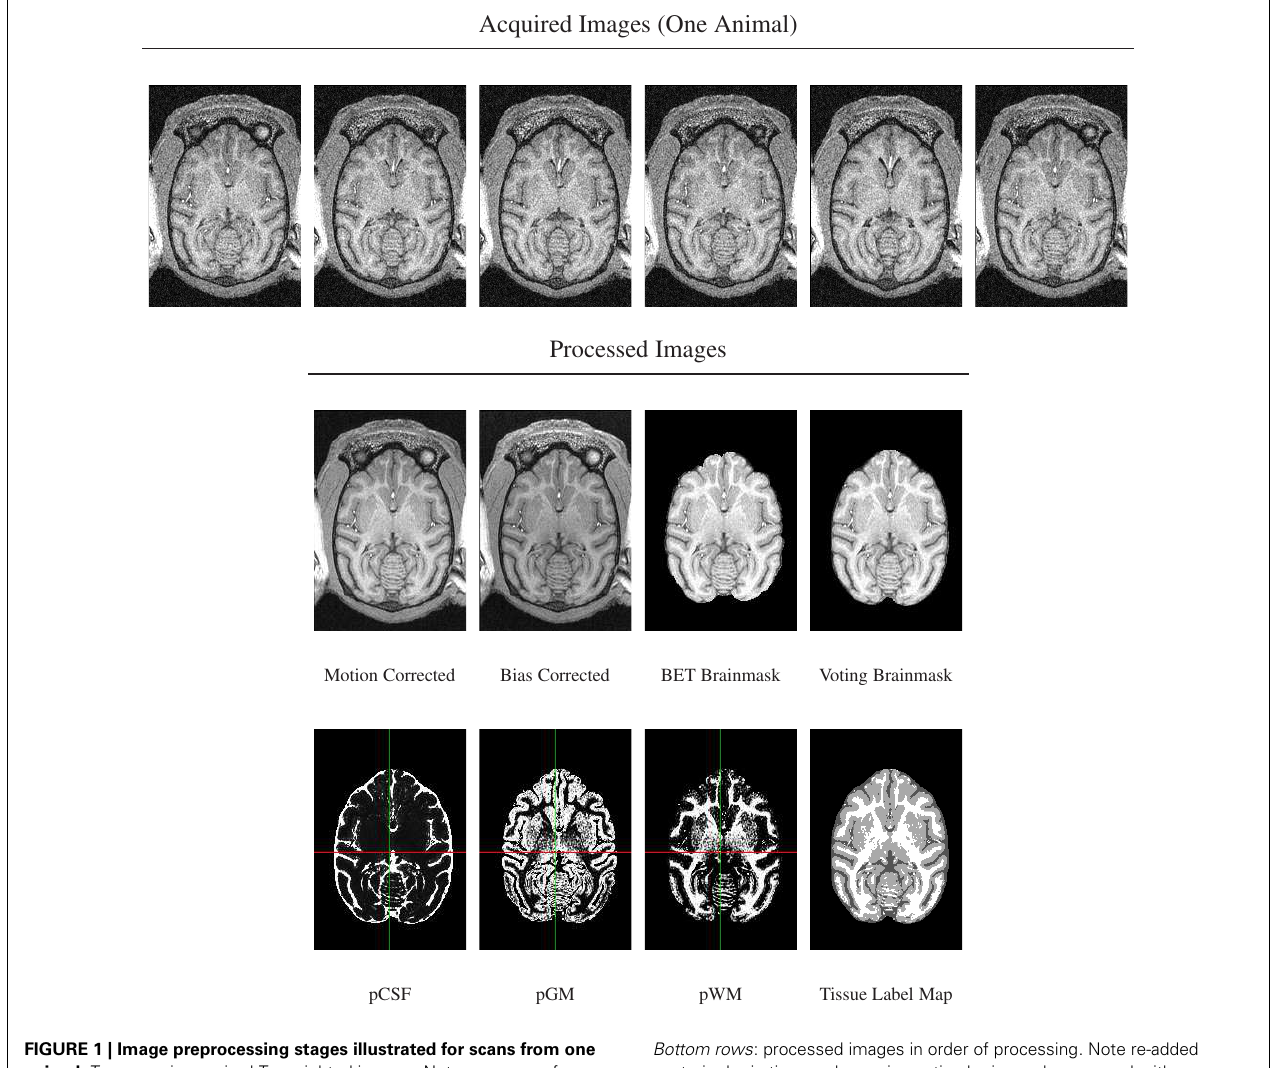
FIGURE 1 | Image preprocessing stages illustrated for scans from one animal. Top row : six acquired T 1 -weighted images. Note presence of motion as evidenced by subtle change of cut plane through eye balls.